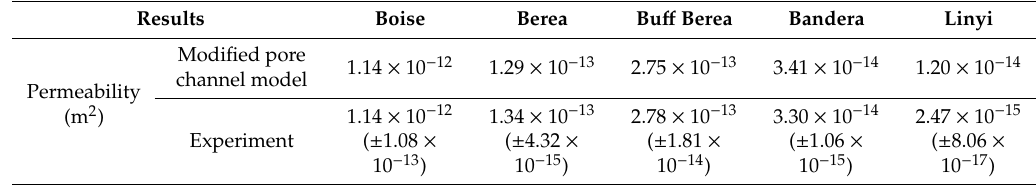
Table 10. Simulation results of permeability from the modified pore channel model using the tortuosity factors derived from applying image processing only to the apparent pore